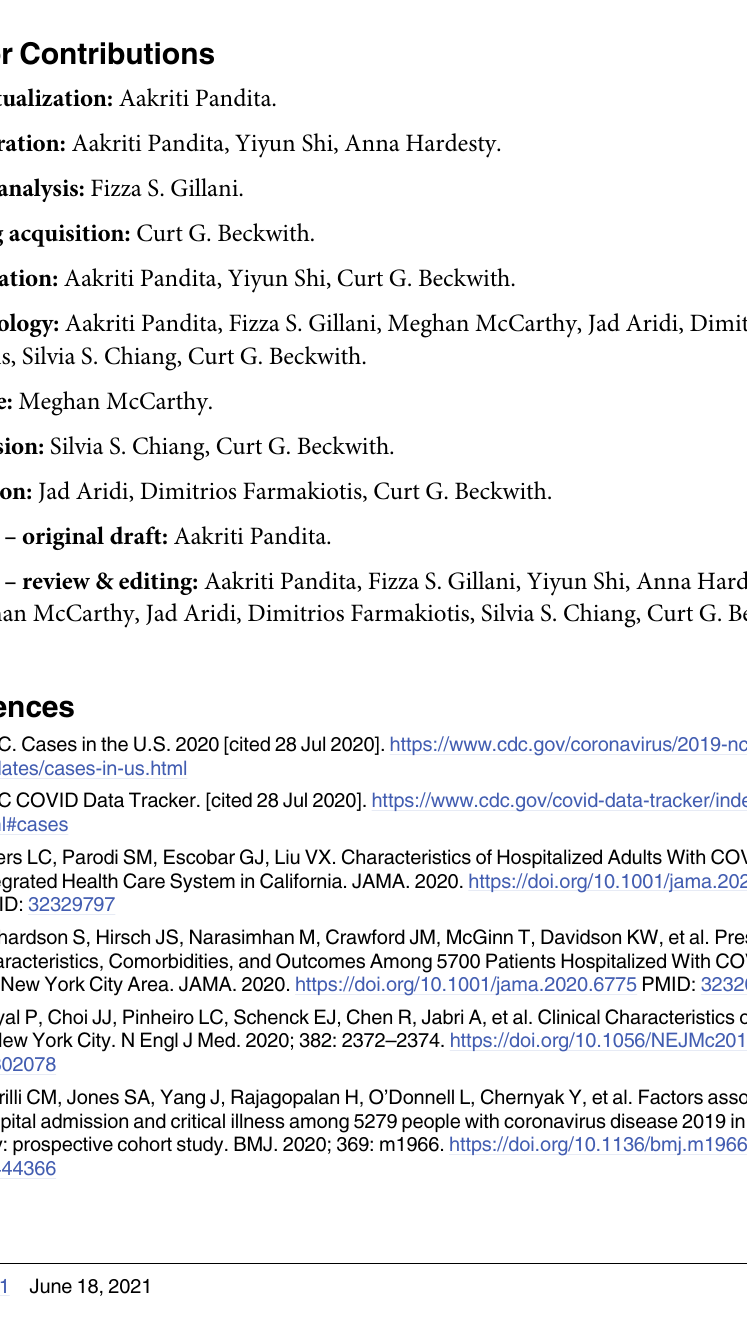
S5 Table. Laboratory values during the first 24 hours of admission. S6 Table. Radiology imaging results during the first 24 hours of